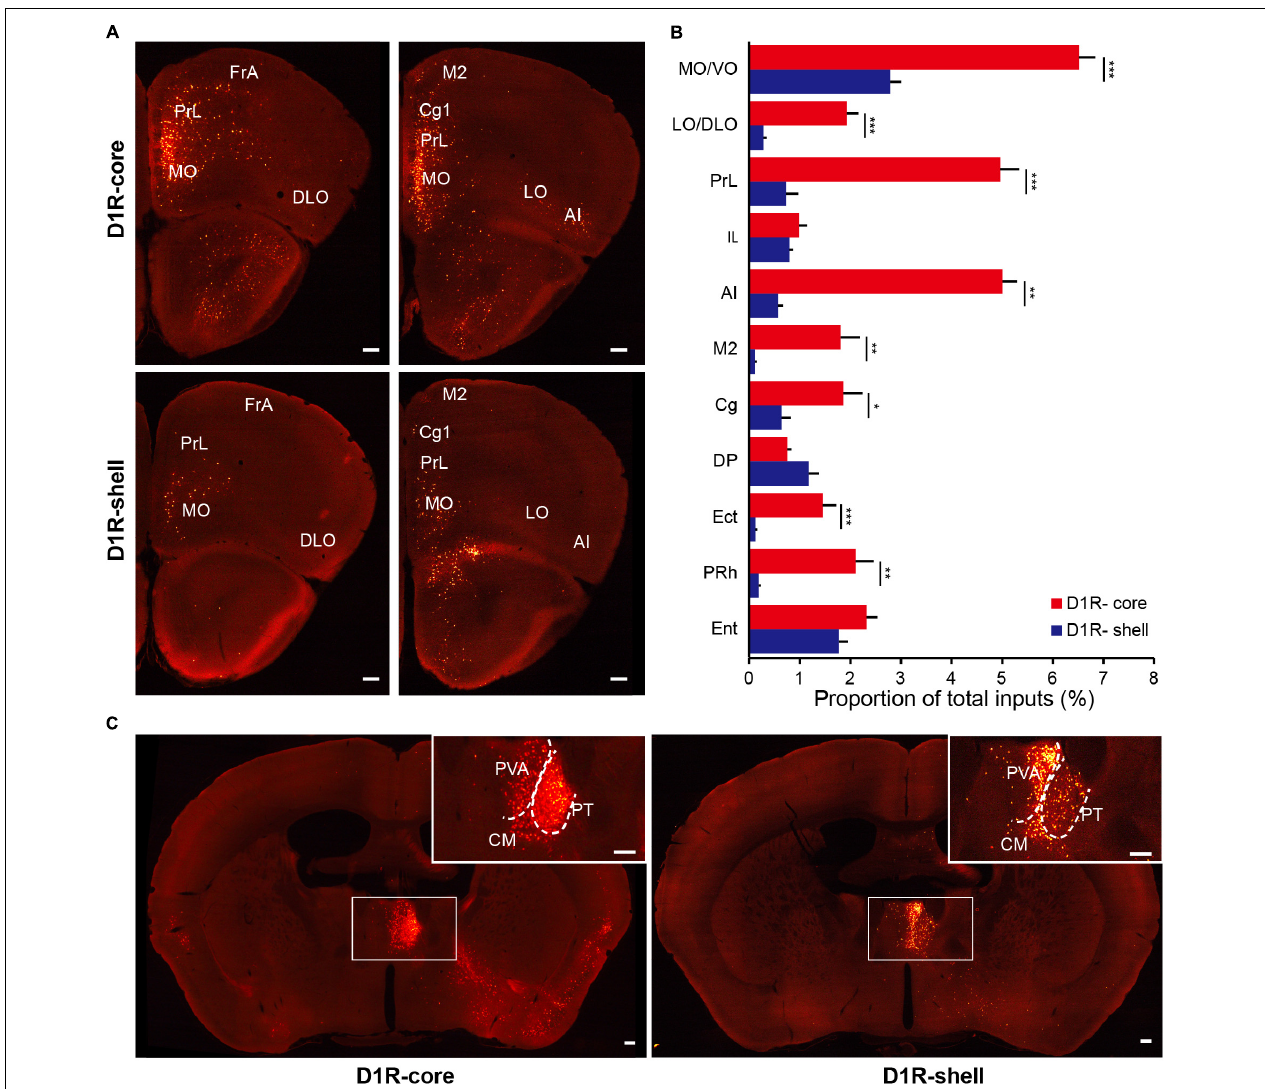
FIGURE 5 | Monosynaptic inputs to D1R-MSNs from the cortex and thalamus. (A) Distributions of anterior cortex inputs to D1R-MSNs in the NAc core (upper panels) and shell (lower panels). Scale bar, 200 µ m. (B) Proportion of total inputs to D1R-MSNs in the NAc core (red) and shell (blue) from 11 cortical areas that contained relatively large numbers of input neurons ( > 1% in at least one experimental group). Mean ± SEM ( n = 6 mice for each group). ∗∗∗ p < 0.001, ∗∗ p < 0.01, and ∗ p < 0.05, two-tailed unpaired t -test or Mann–Whitney U test. (C) Distributions of thalamic inputs to D1R-MSNs in the NAc core (right) and shell (left). Inset, enlarged view of the area in the white box showing spatially separated labeling. Scale bar, 200 µ